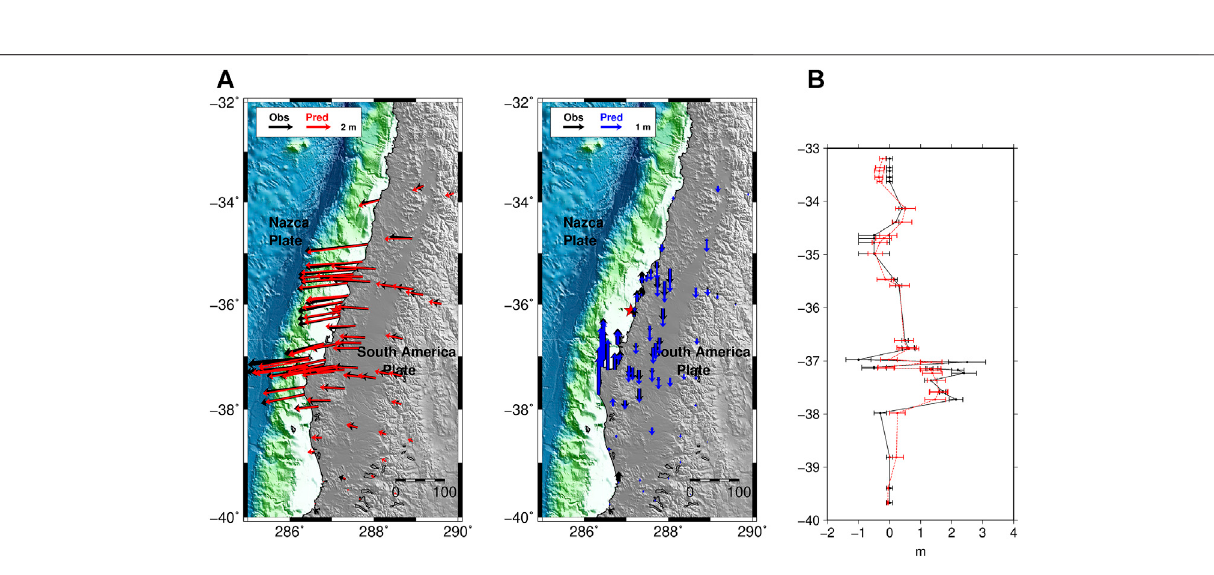
Frontiers in Earth Science |